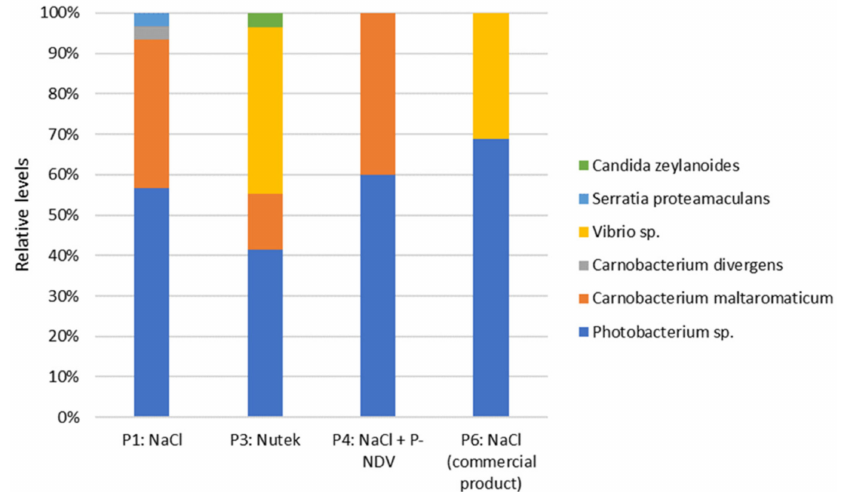
Figure 9. Relative levels of bacteria (and one yeast) in industrially produced CS salmon with NaCl, sodium-reduced salt (Nutek), and variants with added Provian NDV preservative salt. Data obtained by MALDI-TOF MS identification of 30 colonies isolated after 29 days of storage from each